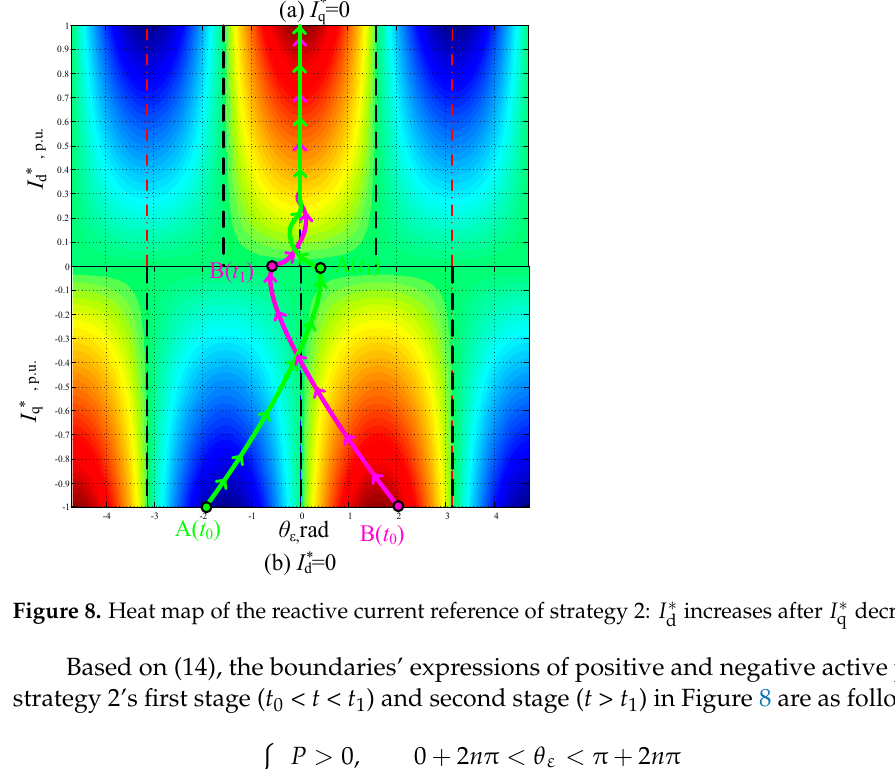
increases after I ∗ q decreases to 0. I increases after * I decreases d d q